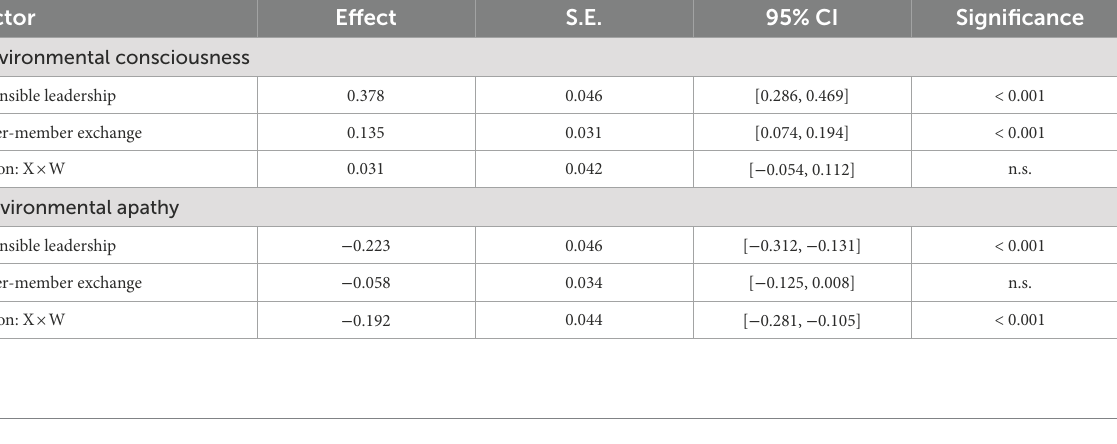
TABLE 5 Regression results for moderating effects. Predictor